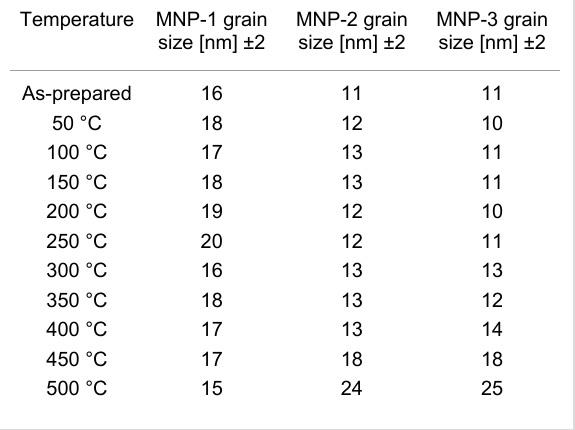
Table 2: Estimated grain sizes of thermally treated nanoparticles, determined by X-ray